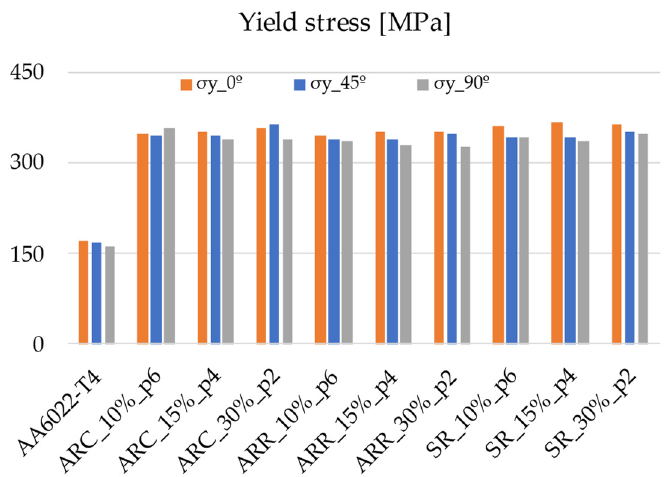
Figure 6. Evolution of yield stress with rolling conditions.